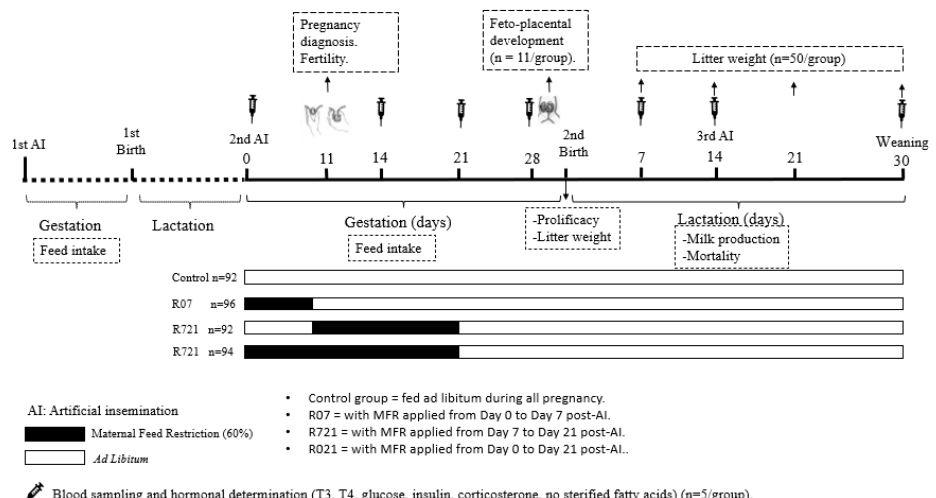
Figure 1. Experimental design.